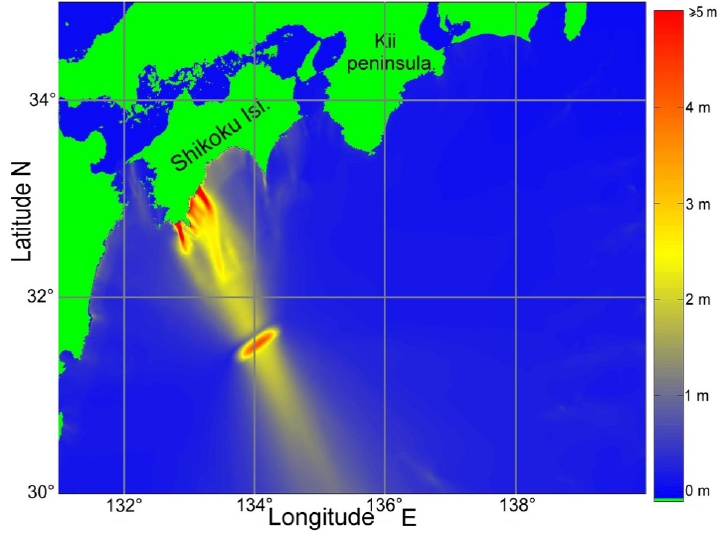
Figure 6. Calculated height maxima in the entire computational domain from a tsunami wave generated by source S0-c (see Figure 3).